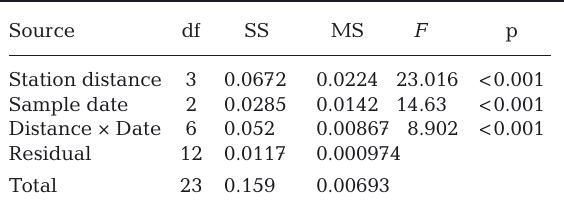
Table 4. Navy Island sediment characteristics. See Table 3 for definitions